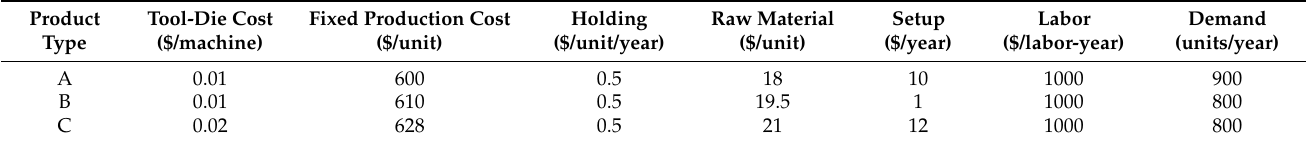
Table 3. Automobile industry manufacturer data.